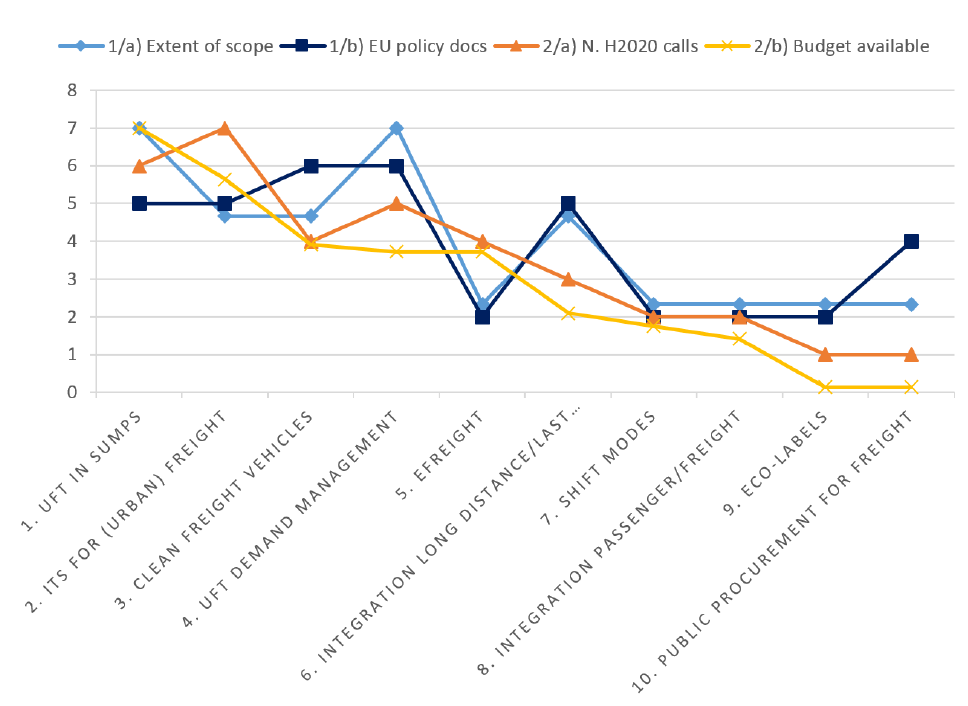
Figure 1: Analysis of the selected UFT policy